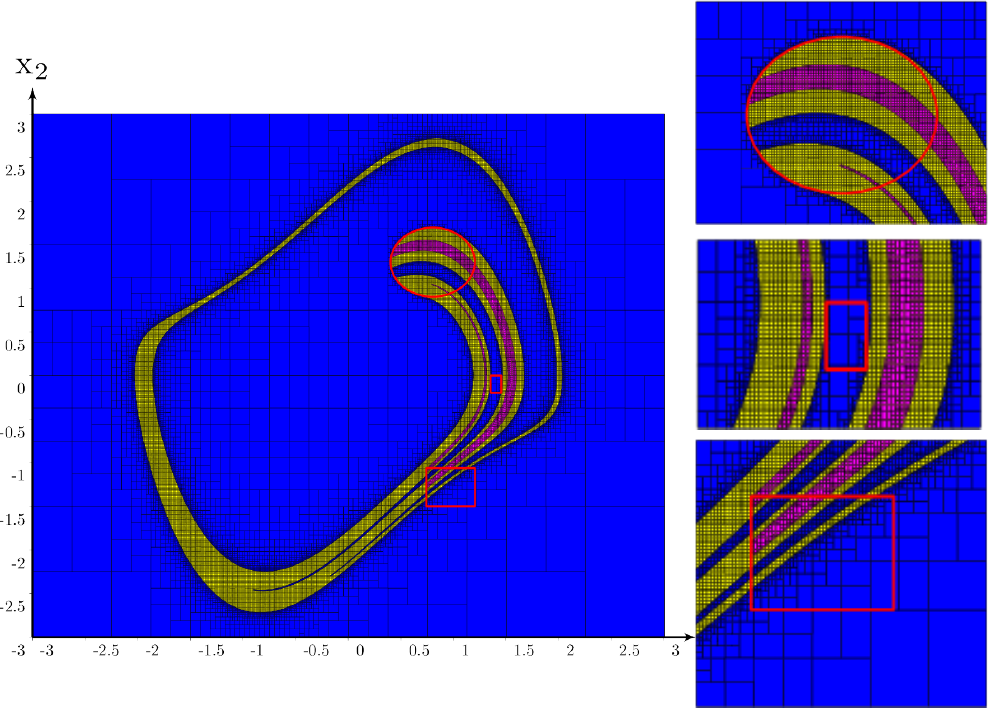
Figure 13. Paths starting from A , avoiding B , and reaching C